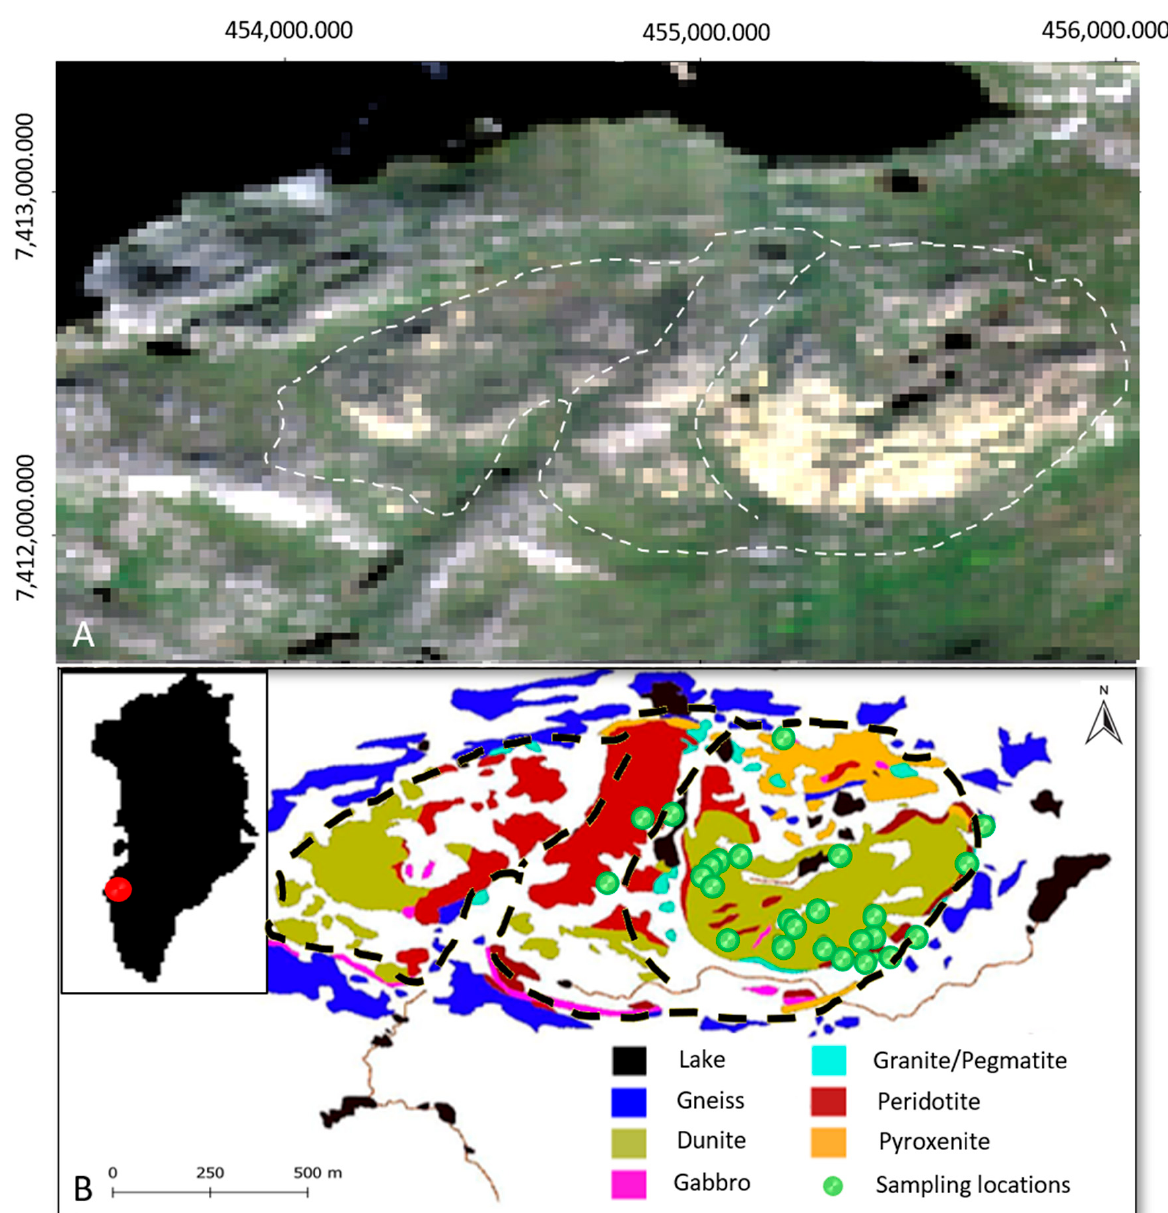
Figure 1. ( A ) True color HyMap image of the Niaqornarssuit Complex and ( B ) generalized geological map (1:10,000) of the Niaqornarssuit Complex (modified from [37]) with 23 rock sample locations (green marks) collected by the mineral exploration company 21st North Exploration and geochemically analyzed by the University of Potsdam. The white ( A ) and black ( B ) dashed polygon lines outline the ultramafic complex with a highlighted intrusion.